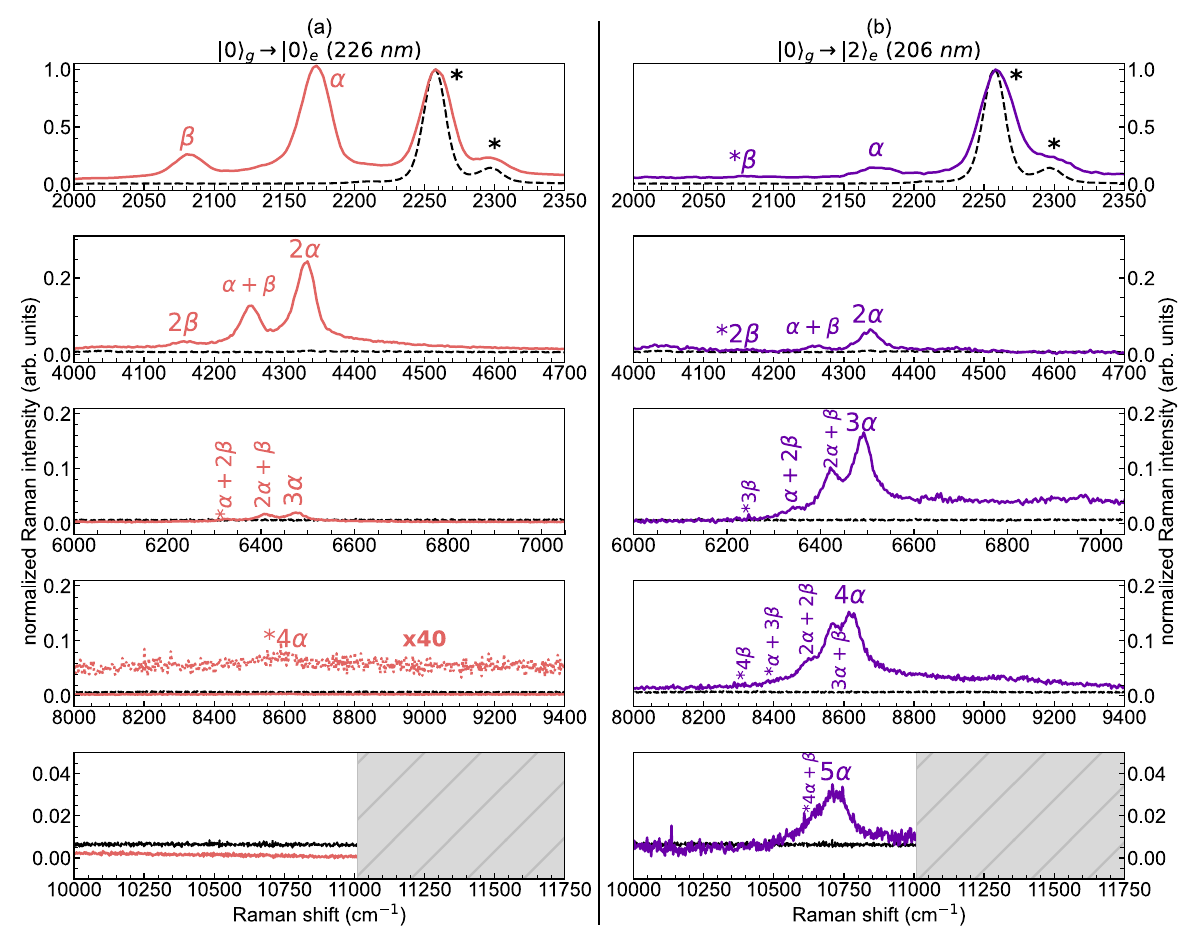
Fig. 2 | Comparison between UV resonance Raman spectra of C 8 at different resonanceconditions. ComparisonbetweenvibrationalbandsofC 8 excitedattwo different resonances, namely 226nm ( ∣ 0 i g ! ∣ 0 i e , a ) and 206nm ( ∣ 0 i g ! ∣ 2 i e , b ). First-andhigh-orders α and β peaksareshown,aswellascombinationbandspeaks ( m α + n β ). The black dashed lines in all the panels are the spectra of the solvent,